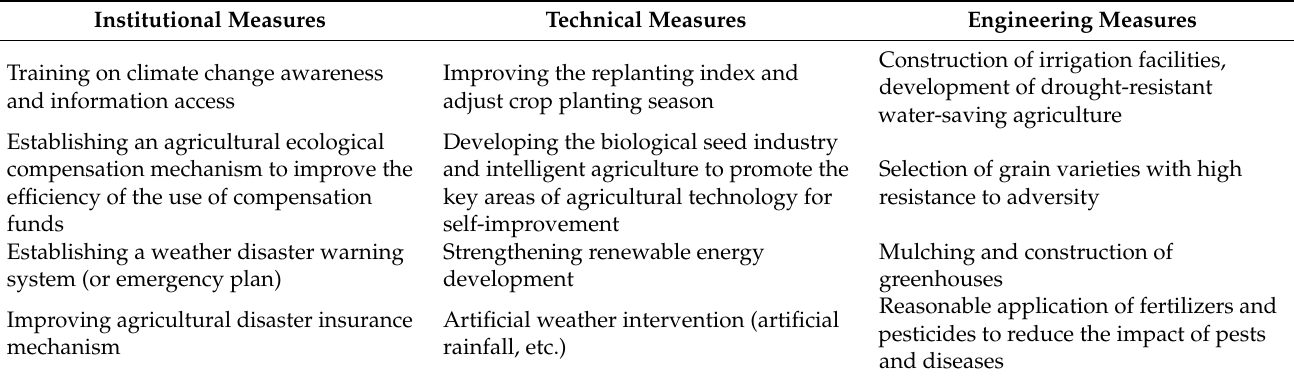
Table 3. Adaptive management measures for climate change in agricultural areas.